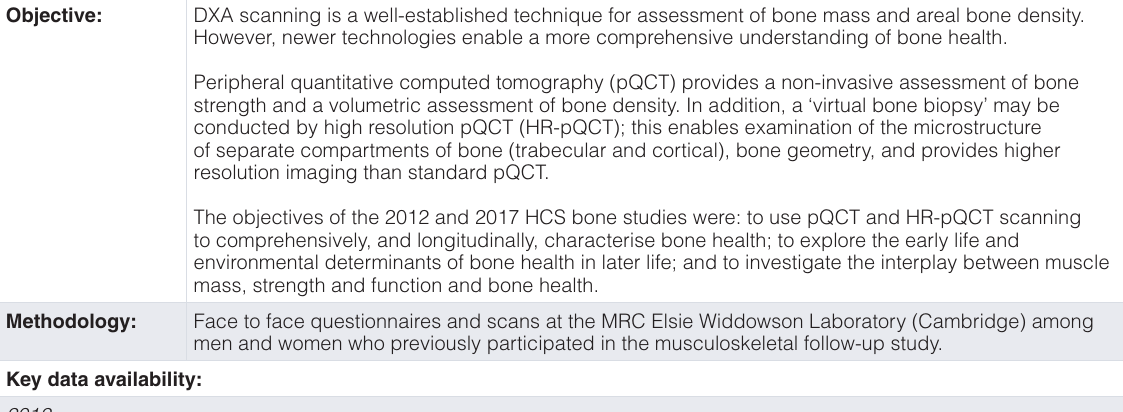
Table 9. Hertfordshire Cohort Study bone studies: 2012 and 2017.